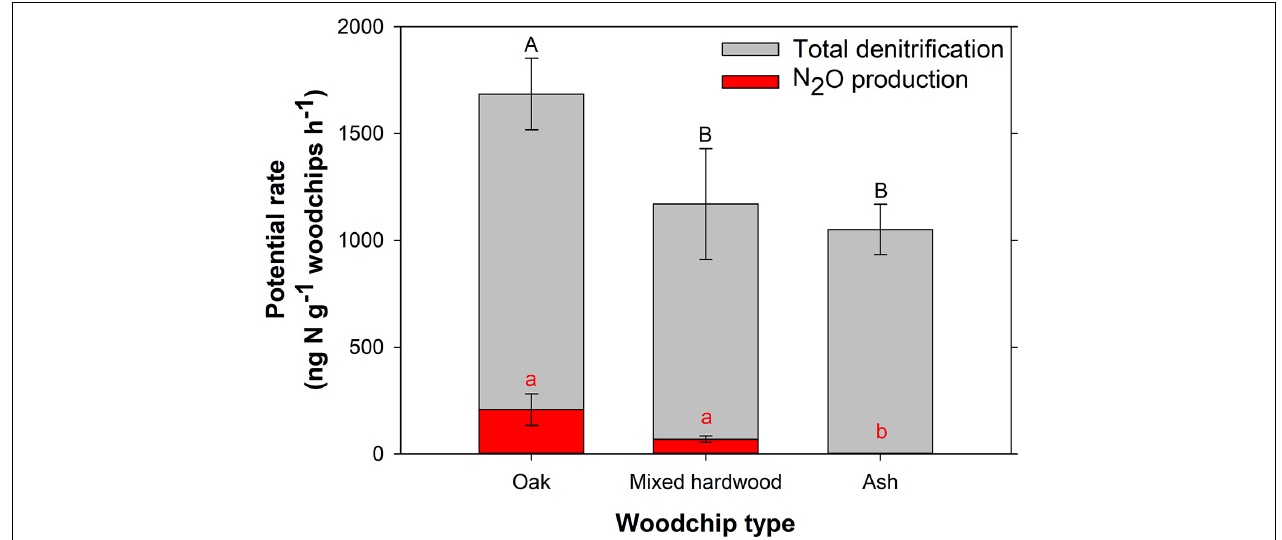
FIGURE 2 | Total denitrification and nitrous oxide (N 2 O) production potentials for the three woodchip types. Error bars represent the standard deviation of three replicates. Different letters denote a statistically significant difference between potential rates ( p < 0.05), with capital letters for total denitrification and lower-case letters for N 2 O